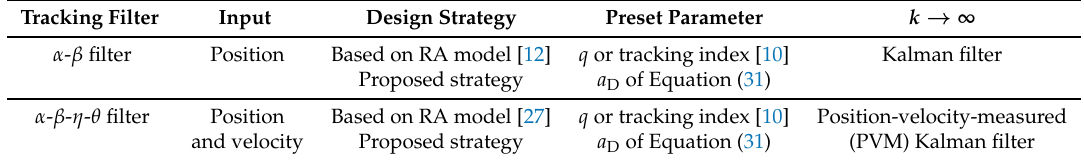
Table 2. Summary of the conventional and proposed tracking filters and design strategies.